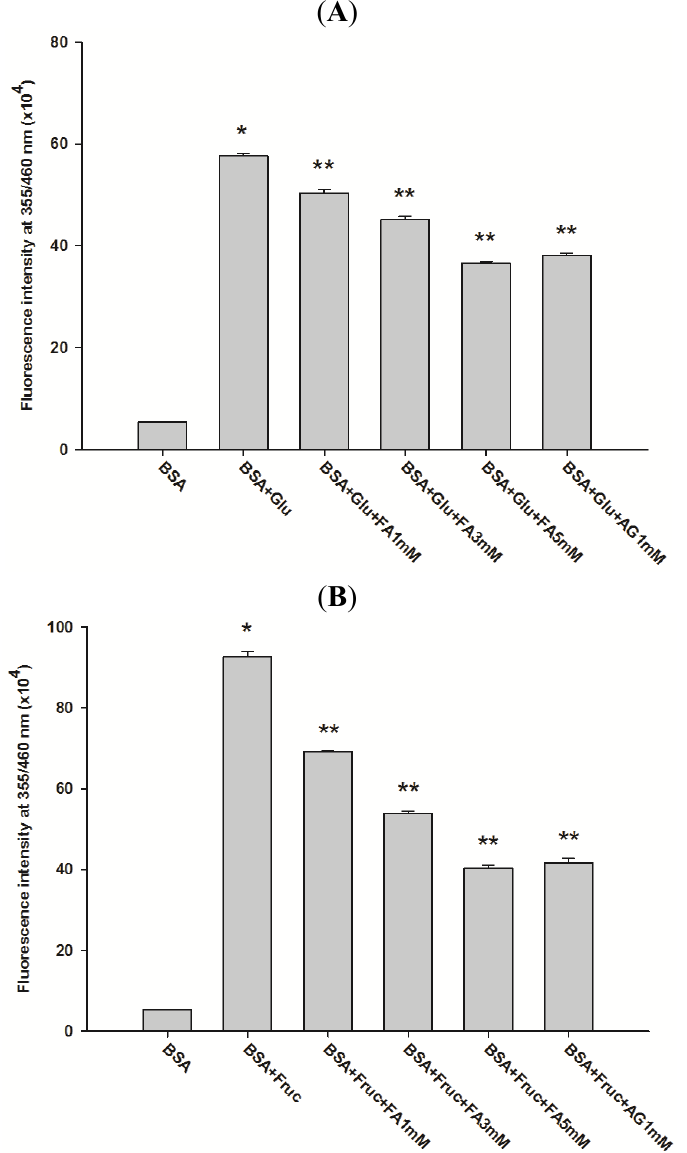
Figure 2. Effect of FA on the fluorescence intensity of BSA incubated with glucose ( A ), fructose ( B ), and ribose ( C ) at week 4. The results are expressed as mean ± SEM ( n =